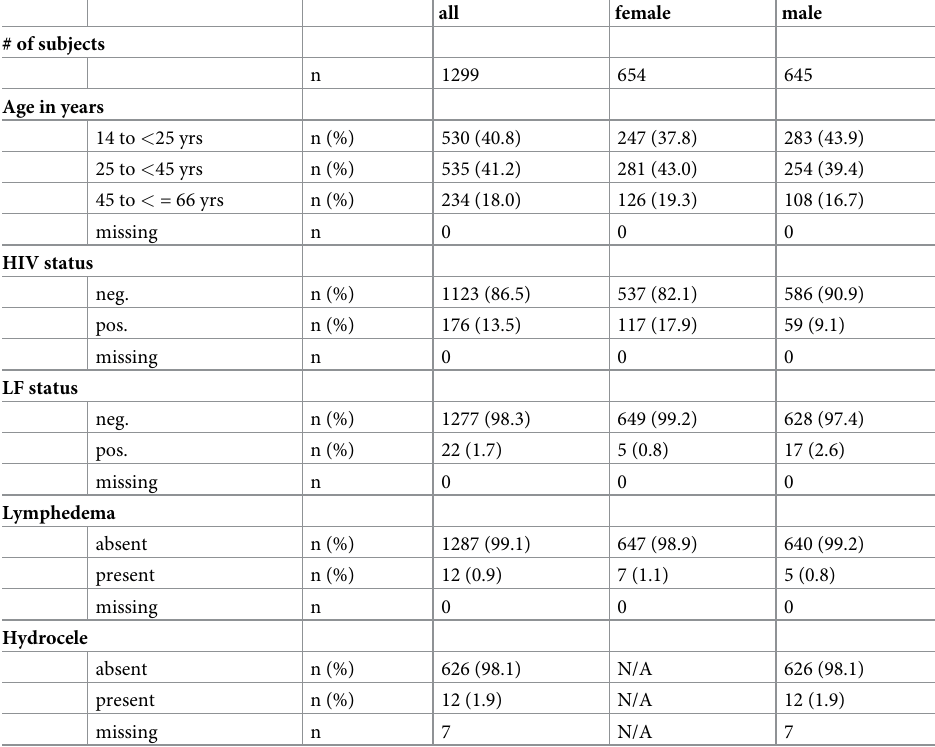
Table 2. Characteristics of the study population in 2019 (RHINO study). all female